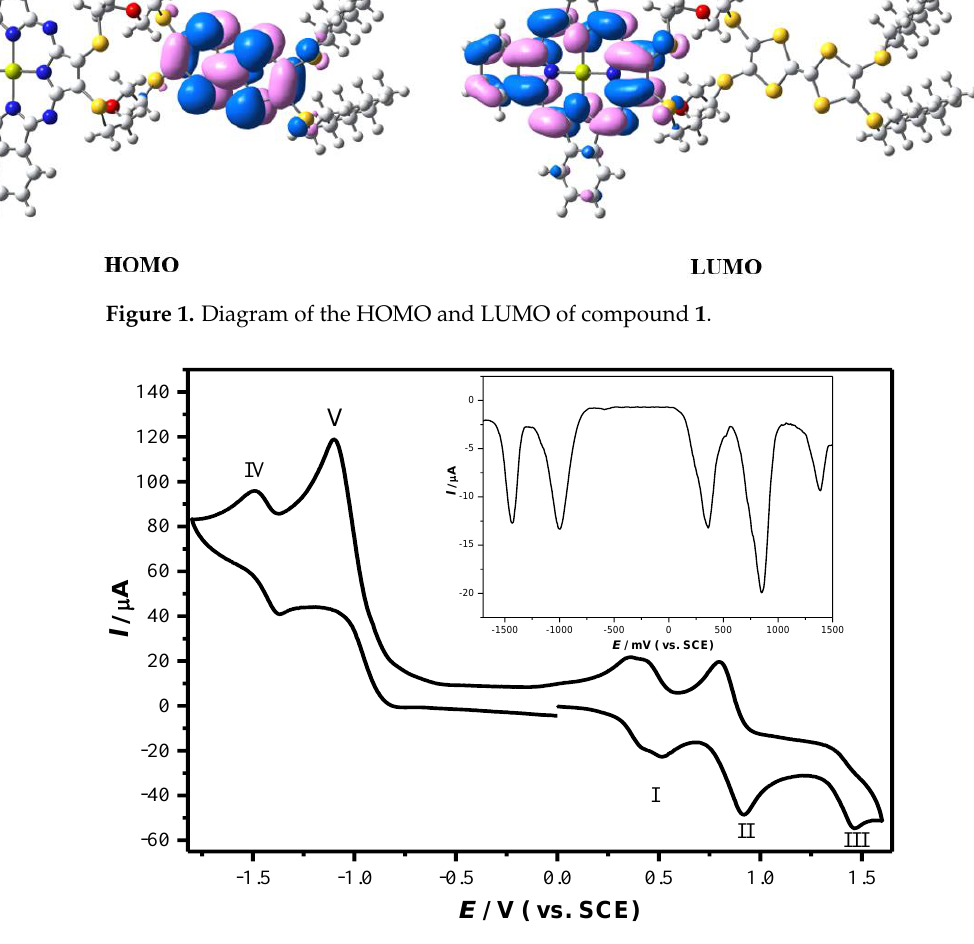
Figure 2. Cyclic voltammetry (CV) of 1 in CH 3 CN-CH 2 Cl 2 (1:5 ( v / v ), 1 × 10 − 3 M) at a scan rate of 100 mV s − 1 . Inset, the differential pulse voltammogram (DPV) of 1 under the same conditions.